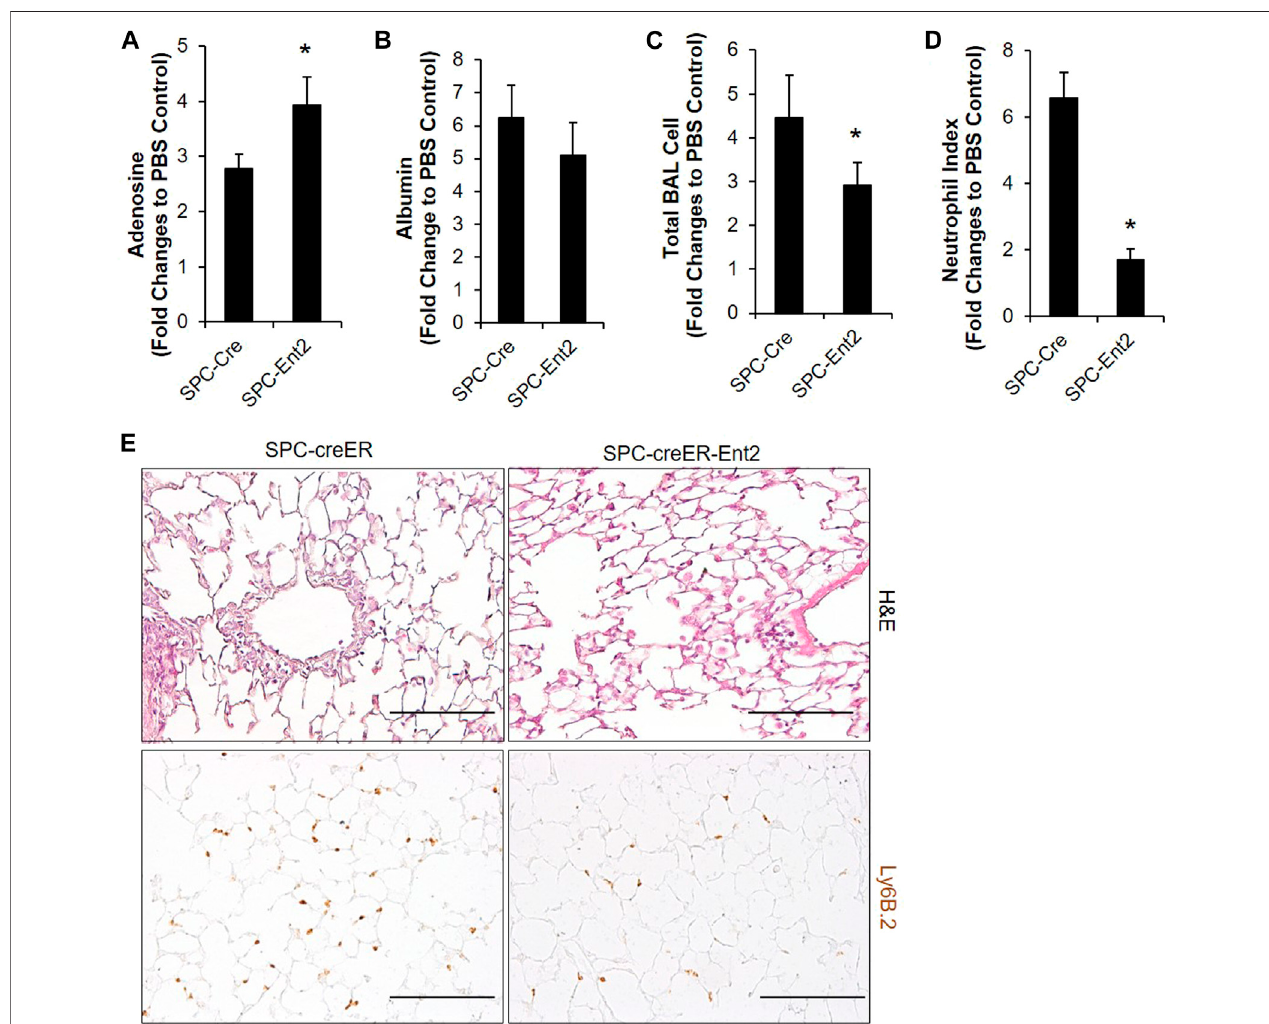
FIGURE2| Bleomycin-inducedALIisattenuatedinmicewithepithelialspeci fi cdeletionofEnt2.SPC-CreER-Ent2 − / − miceorlittermateSPC-CreERcontrolswere i.p. injected with 75 mg/ml tamoxifen daily for 5 days. One week after the fi rst tamoxifen injection, mice were I .t. injected with 2.5 U/kg bleomycin. On day 3, BAL adenosine (A) and albumin levels (B) , and total BAL cell number (C) were analyzed. (D) Neutrophil in fi ltration was determined by staining with anti-Ly6B.2, and